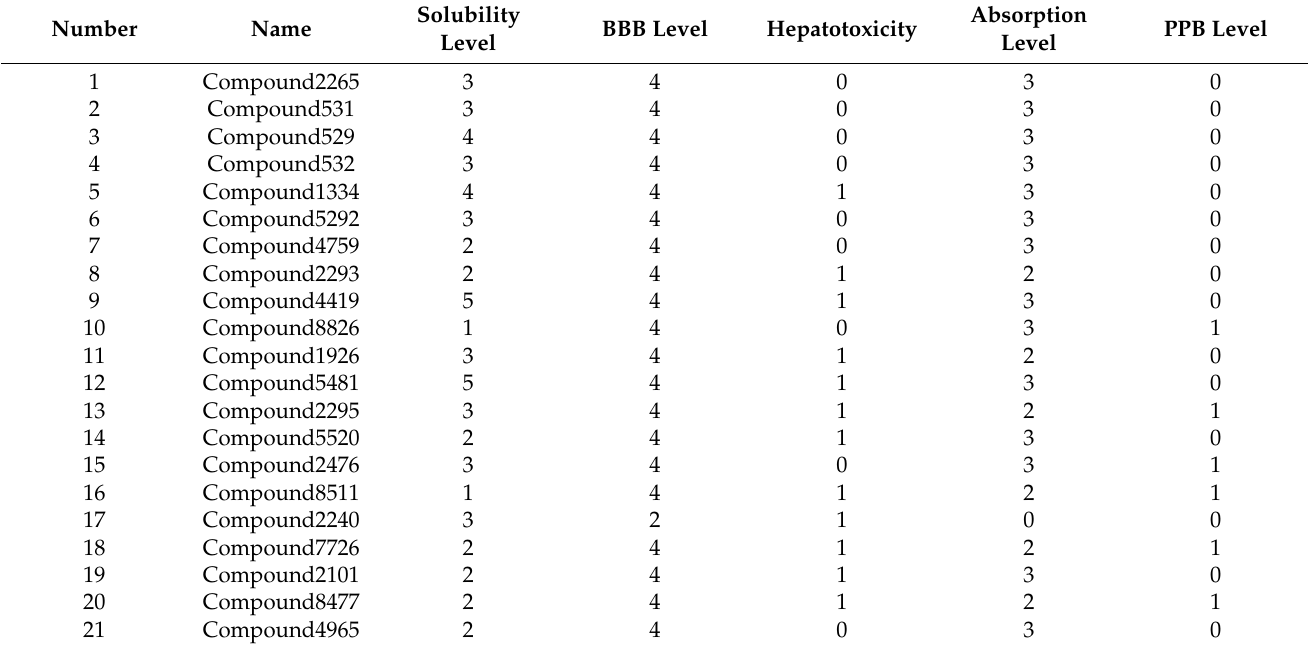
Table 3. Pharmacologic properties of